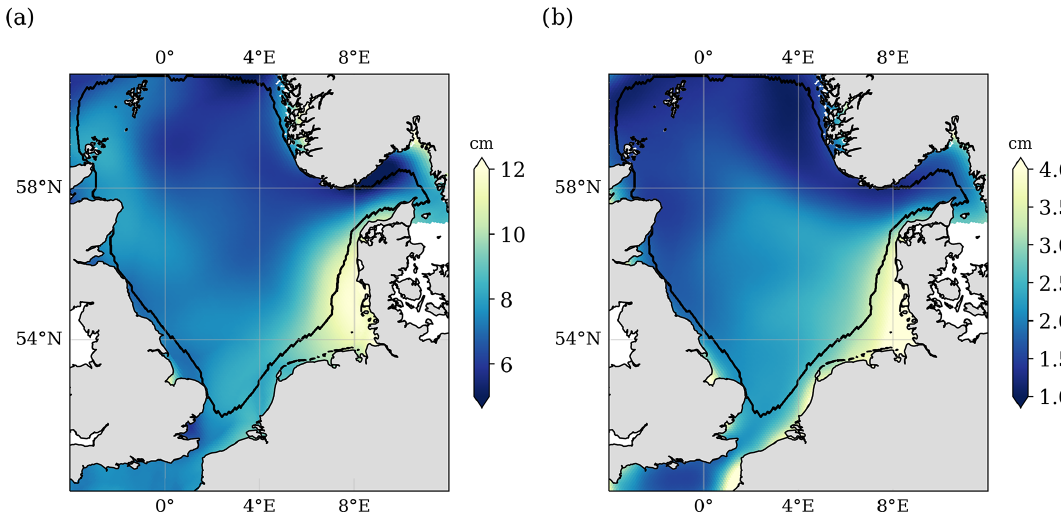
Figure 5. Amplitudes of the annual cycle of the sea level (a) and associated uncertainties (b) for the period 1995–2019. The black contour line confines the coastal regions flagged in the dataset.